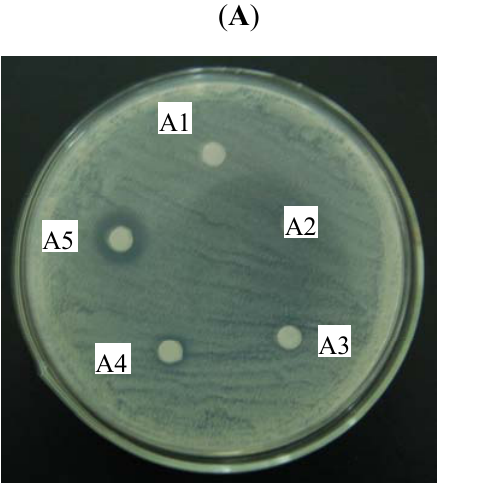
Figure 3. Agar disk diffusion assay with various concentrations of BCA alone ( A )